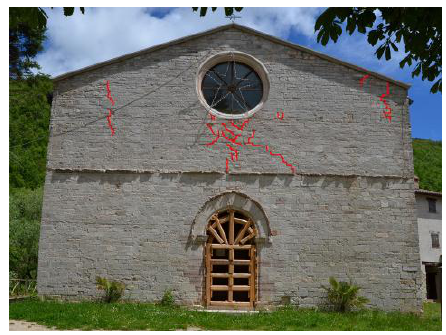
Figure 18. Post-2016 earthquake damage of the external façade with the damage pattern.